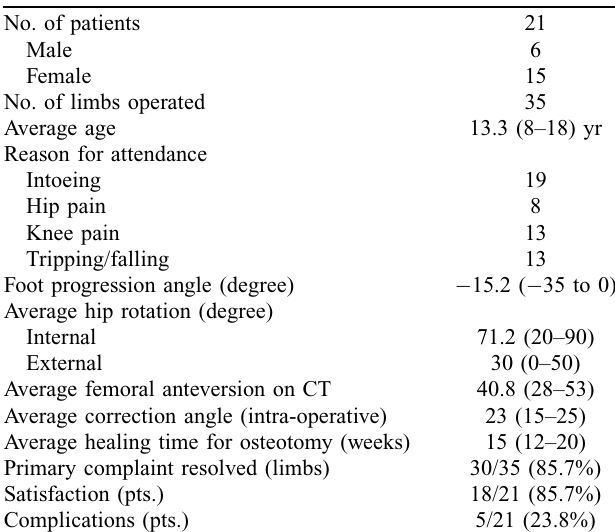
Table 1. Descriptive data on patients with proximal femoral derotation osteotomy for excessive femoral